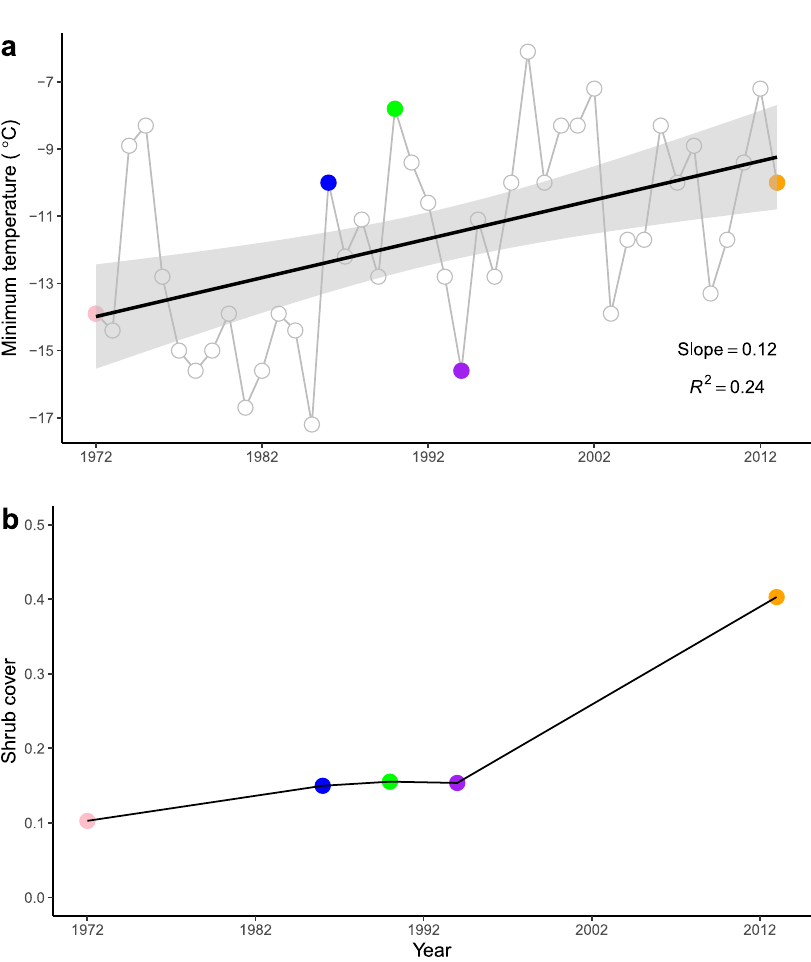
Fig. 2 Long-term changes in minimum temperature and shrub cover. a Changes in annual lowest minimum temperature in Painter station, Virginia from 1972 to 2013. b Shrub cover change on Hog Island, Virginia from 1972 to 2013. The shaded area represents the 95% con fi dence interval range.